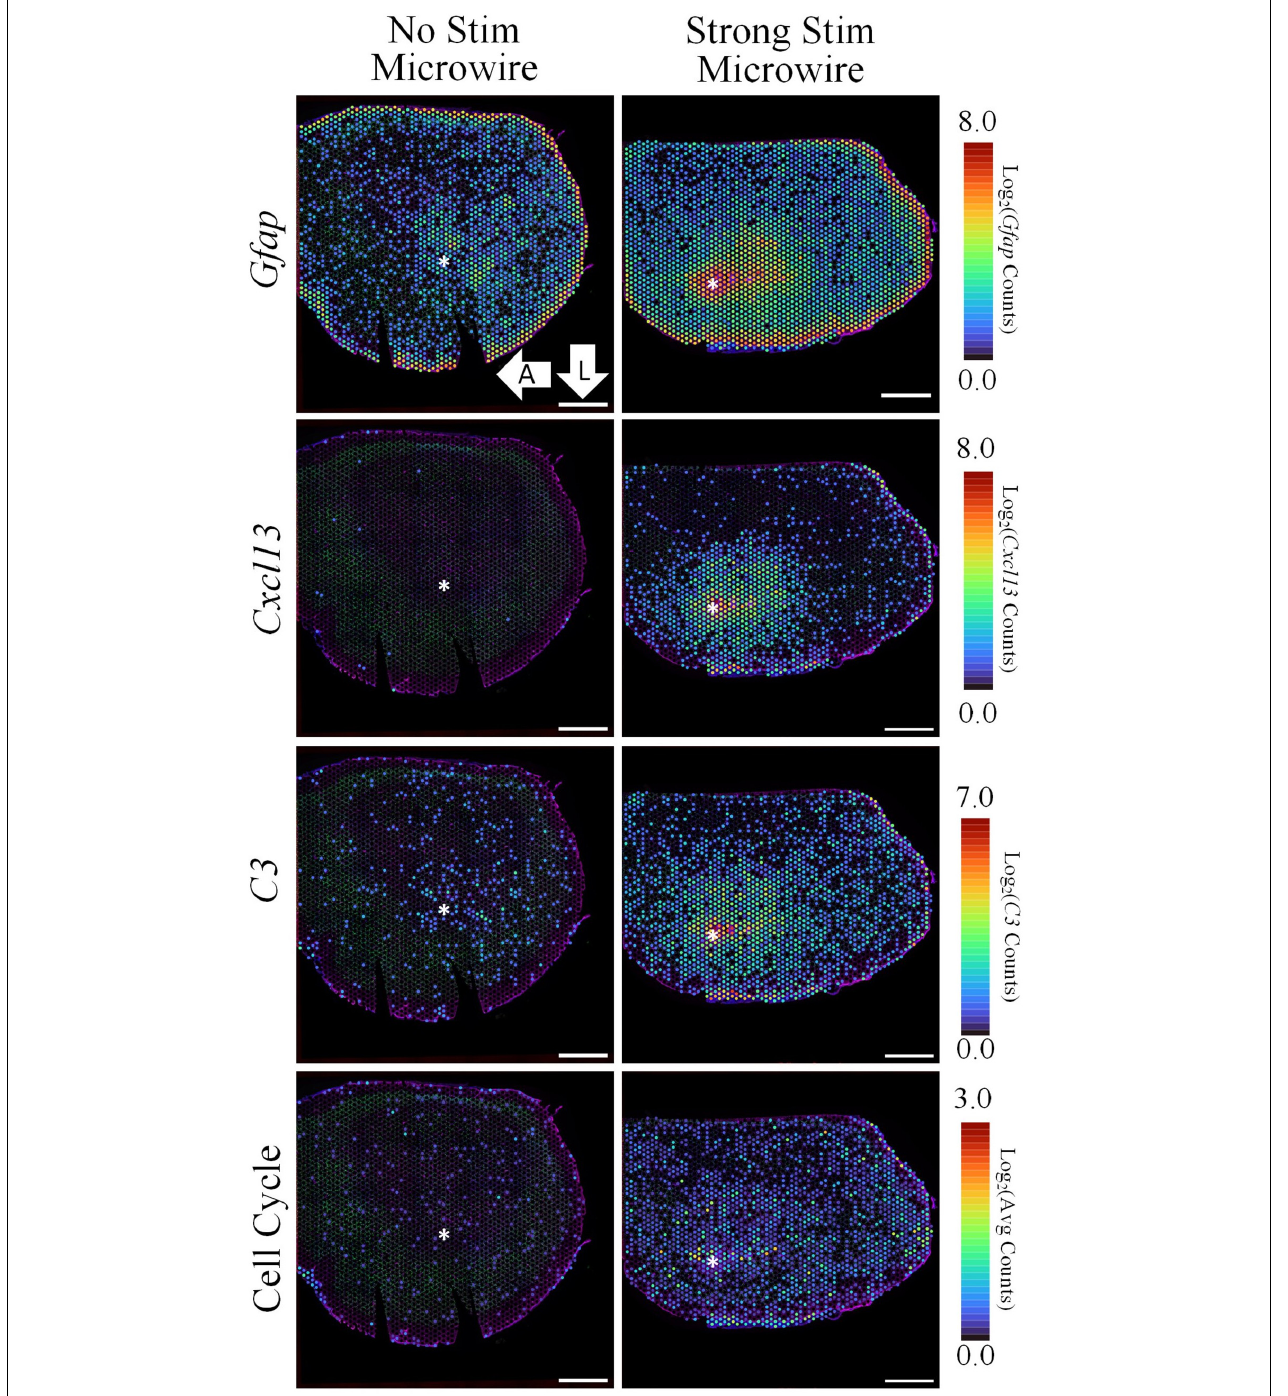
FIGURE 9 | The spatial pattern of selected DE genes illustrate the upregulation of inflammation and cell cycle-associated pathways following electrical stimulation delivered by a MWA in comparison to no stimulation. Stimulation delivered by the MWA is associated with increased expression of genes included in a cytotoxic, “Cell-Killing” gene ontology term ( C3 , Cxcl13 ). Upregulation of cell cycle-associated genes with the MWA-stimulation condition was an unexpected result revealed by the spatial transcriptomics assay. Average expression of DE genes making up the “Cell Cycle” GO Term. Asterisks denote estimated implant site and arrows denote direction (L: lateral, A: anterior). Scale bars: 1.0